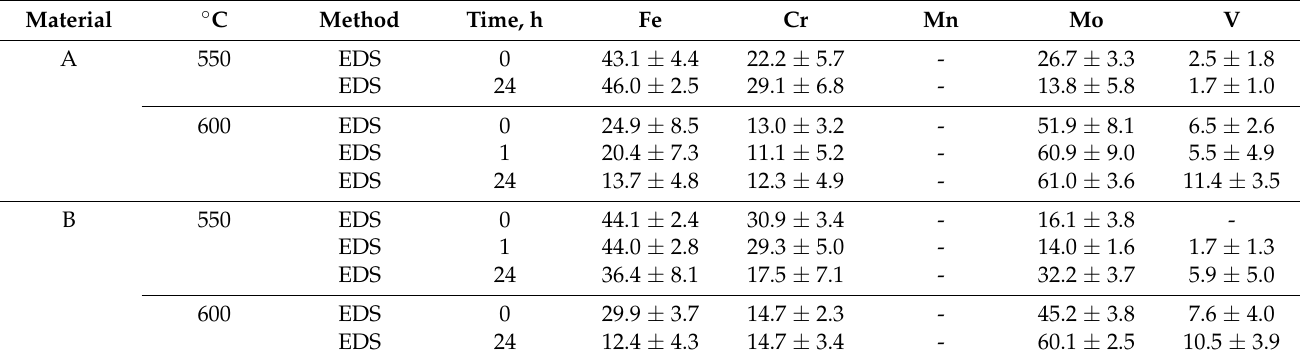
Table 4. At% of metal constituents in Mo-rich